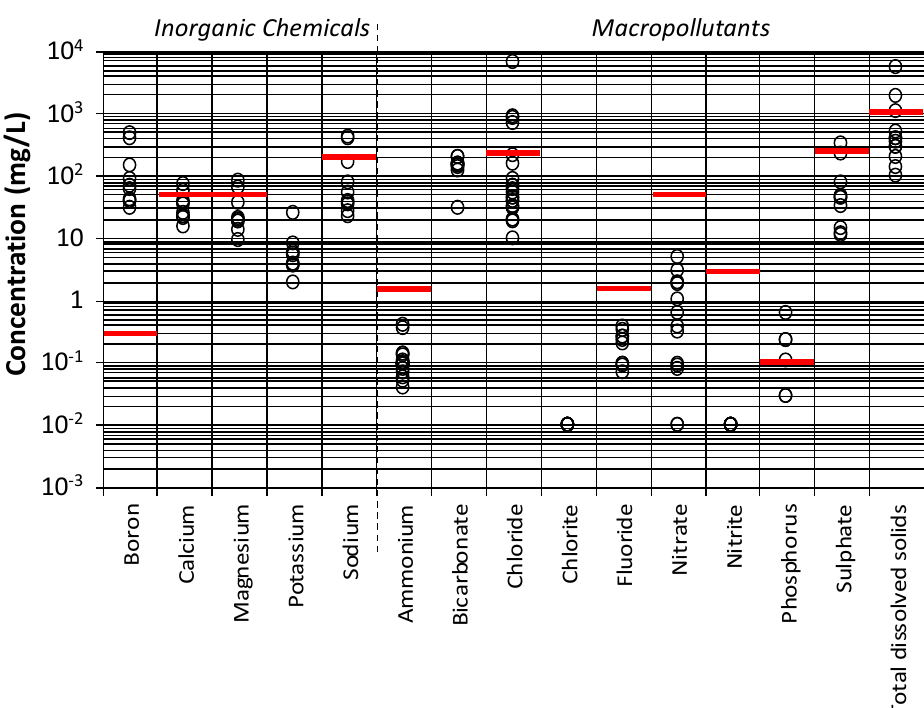
Figure 4. Observed concentrations (circles) of inorganic chemicals and macropollutants in surface water in the reviewed studies referring to Mozambique and the corresponding limits (red dashes) set by current national legislation (red line) for drinking water. Data from: [27,29]. As to pollutants in MZ surface water (Figure 4), it was found that based on the modest number